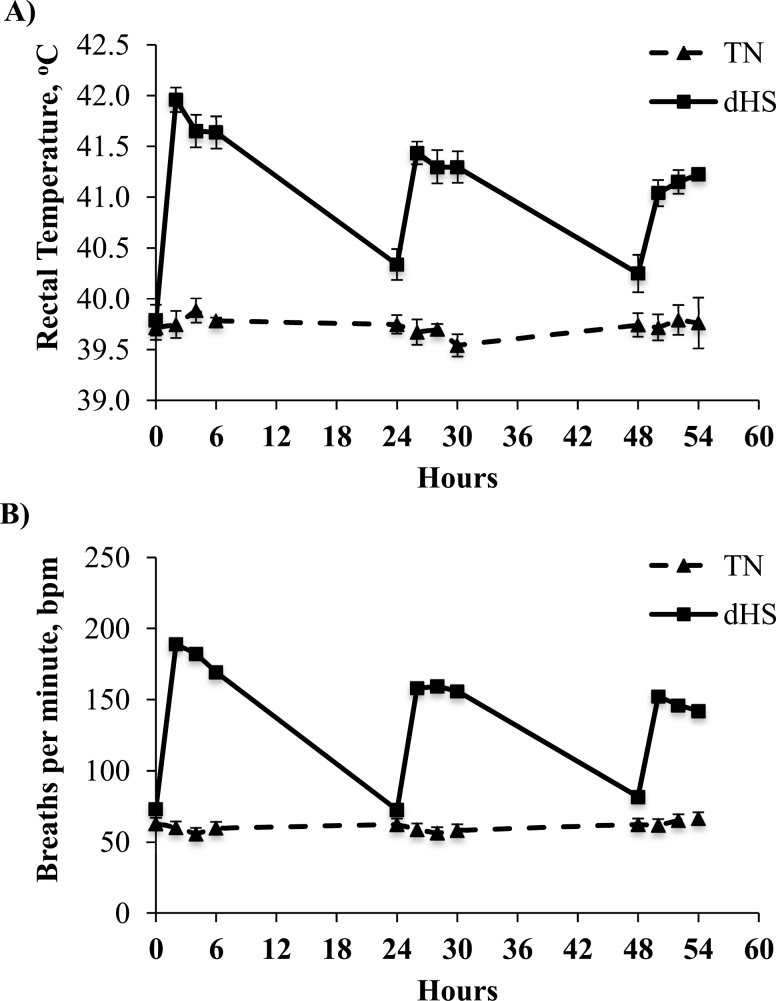
Time course effect of 3 d dHS (6 h at 38°C, 40–60% humidity followed by 18 h at 32°C, 40–60% humidity) or constant TN conditions (28°C; 40–60% humidity) on pig (A) rectal temperature and (B) respiration rates (breaths per min, bpm). n = 24/treatment/time point.